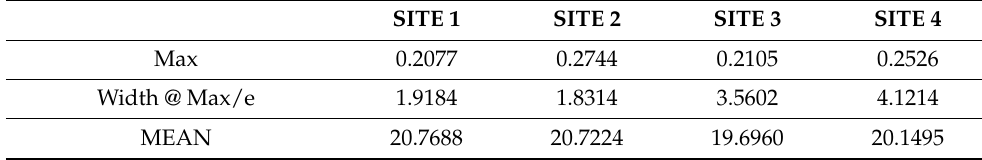
Table 5. Quality of the y-y spectrum inertia as a